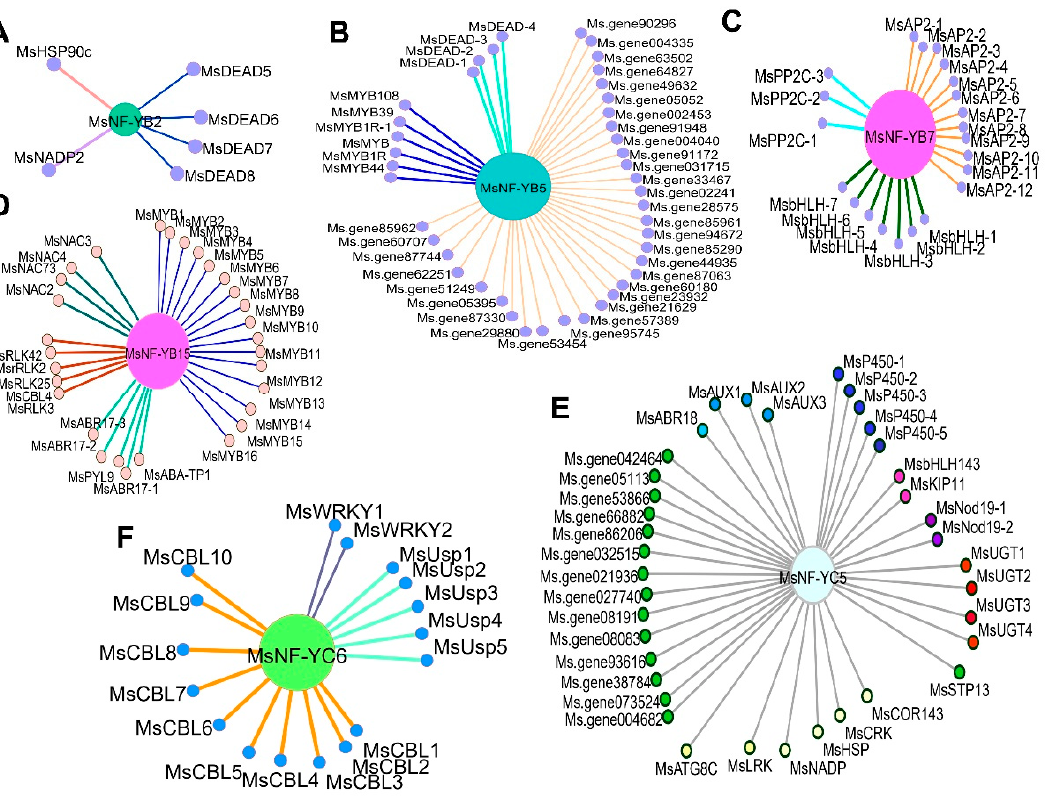
Figure 10. Coexpression network of the six MsNF-Y genes under salt stress. ( A ) The network of MsNF-YB2 , ( B ) MsNF-YB5 , ( C ) MsNF-YB7 , ( D ) MsNF-YB15 , ( E ) MsNF-YC5 , and ( F ) MsNF-YC6 .